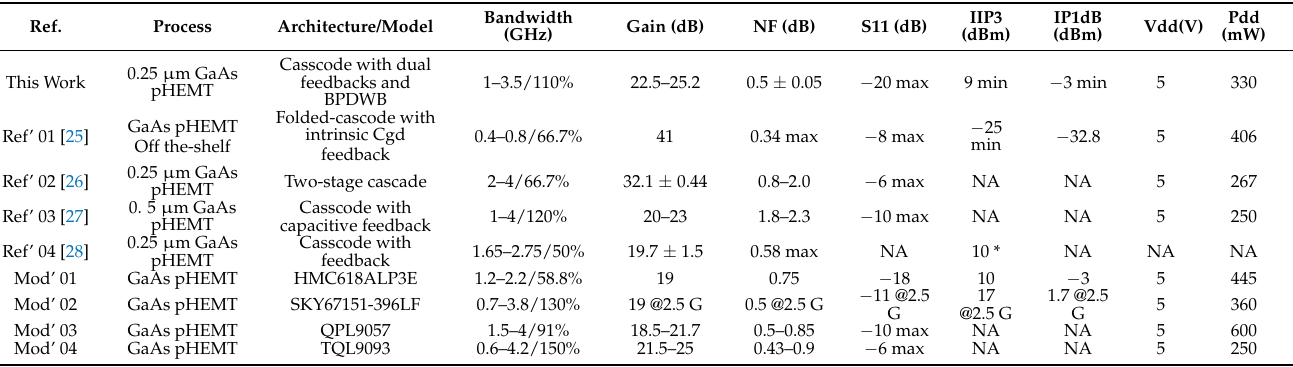
* Calculated from gain and OIP3.